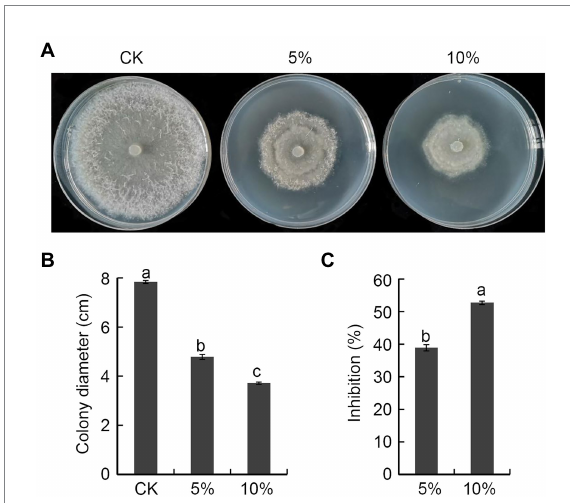
FIGURE 3 The impact of B. halotolerans strain Pl7 culture filtrate on B. dothidea mycelial growth. (A) B. dothidea colony morphology at 6 dpi on PDA medium with 5% or 10% culture filtrate of strain Pl7. (B) Measurements on the colony diameter of B. dothidea . Each dataset is expressed as the mean ± SD of three biological replicates. Different lowercase letters denote significant differences ( p < 0.05; Duncan’s multiple test) between treatments and CK. (C) Rate of inhibition. Each dataset is expressed as the mean ± SD of three biological replicates. Different lowercase letters denote significance ( p < 0.05; Student’s t -test) between treatments. The experiment was performed independently three times with similar results.